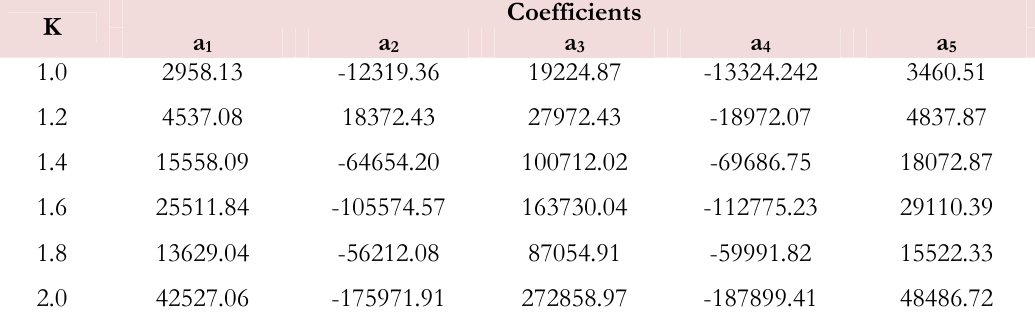
Table 2: The coefficients of Eq. (2) [9].